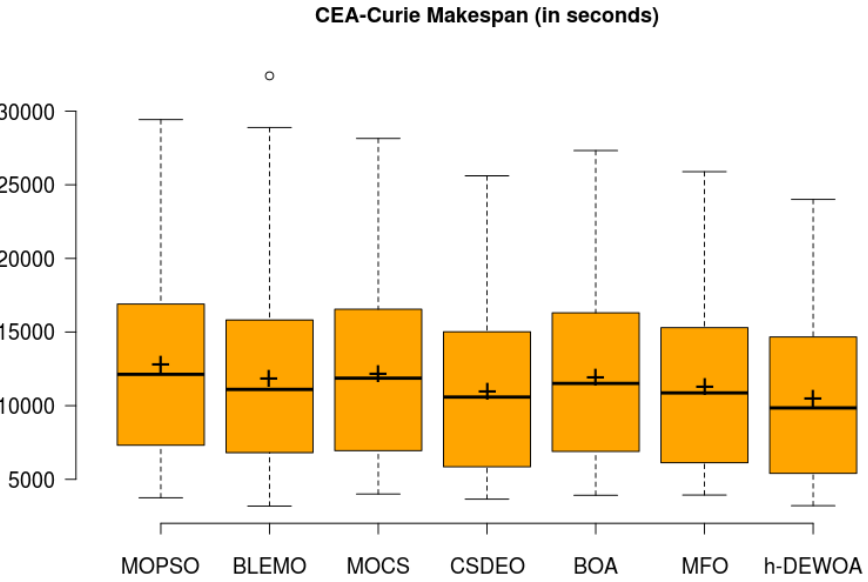
Figure 16. Comparative boxplot analysis of the overall makespan of h-DEWOA and recent state-of-the-art algorithms for CEA-Curie workloads.